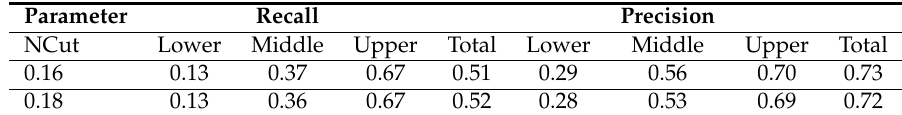
Table 9. Sensitivity analysis for tree detection in reference areas. Bioklim CZ. Total number of trees is 2126.